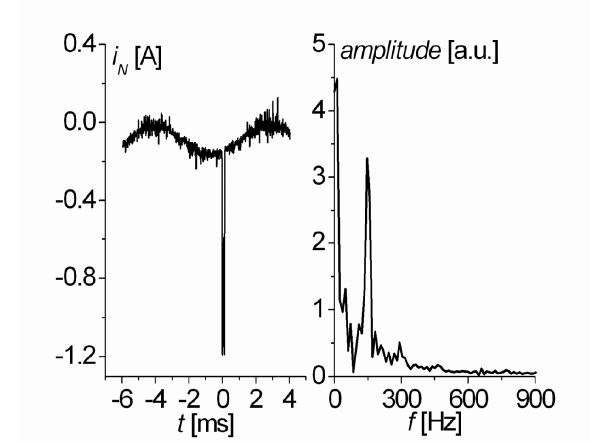
Figure 2: Typical ion current waveform. The FFT analysis is also